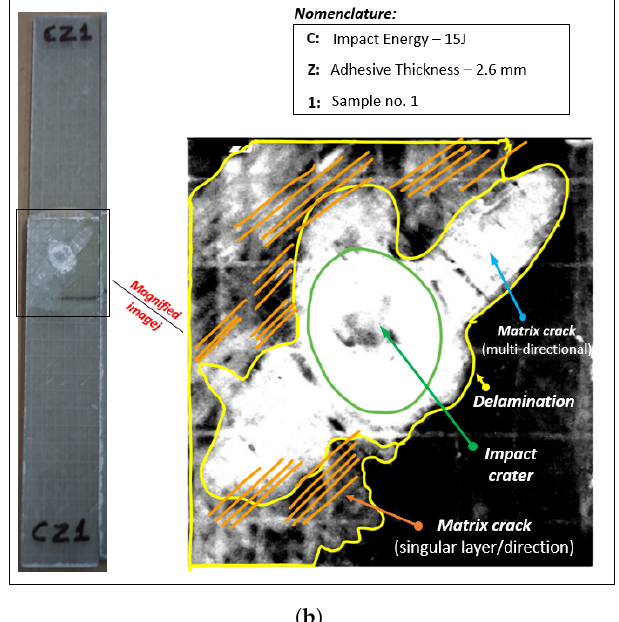
Figure 18. Different failure modes in the joints subjected to impact energy of 15 J for bondline thickness of ( a ) 0.6 mm and ( b ) 1.6